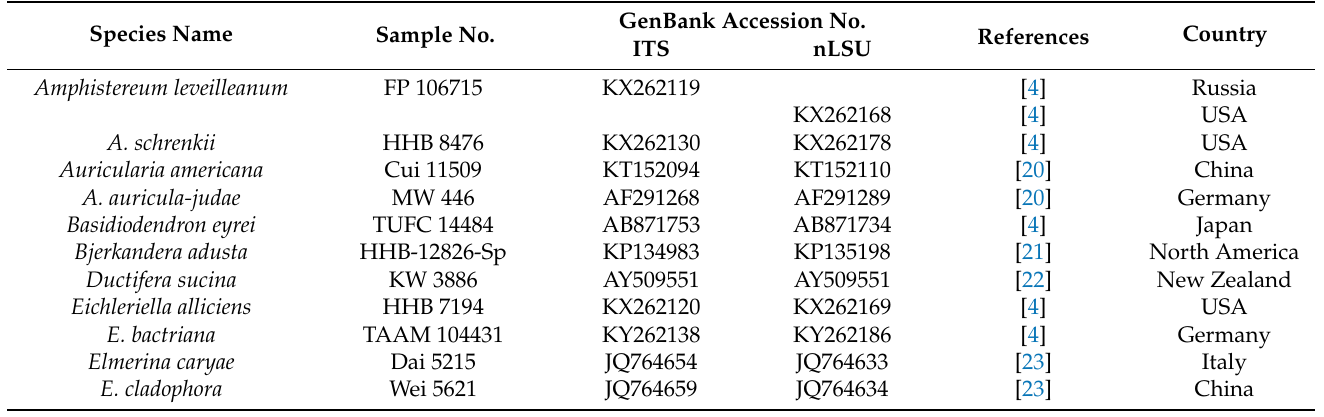
Table 1. List of species, samples, and GenBank numbers of sequences employed in present